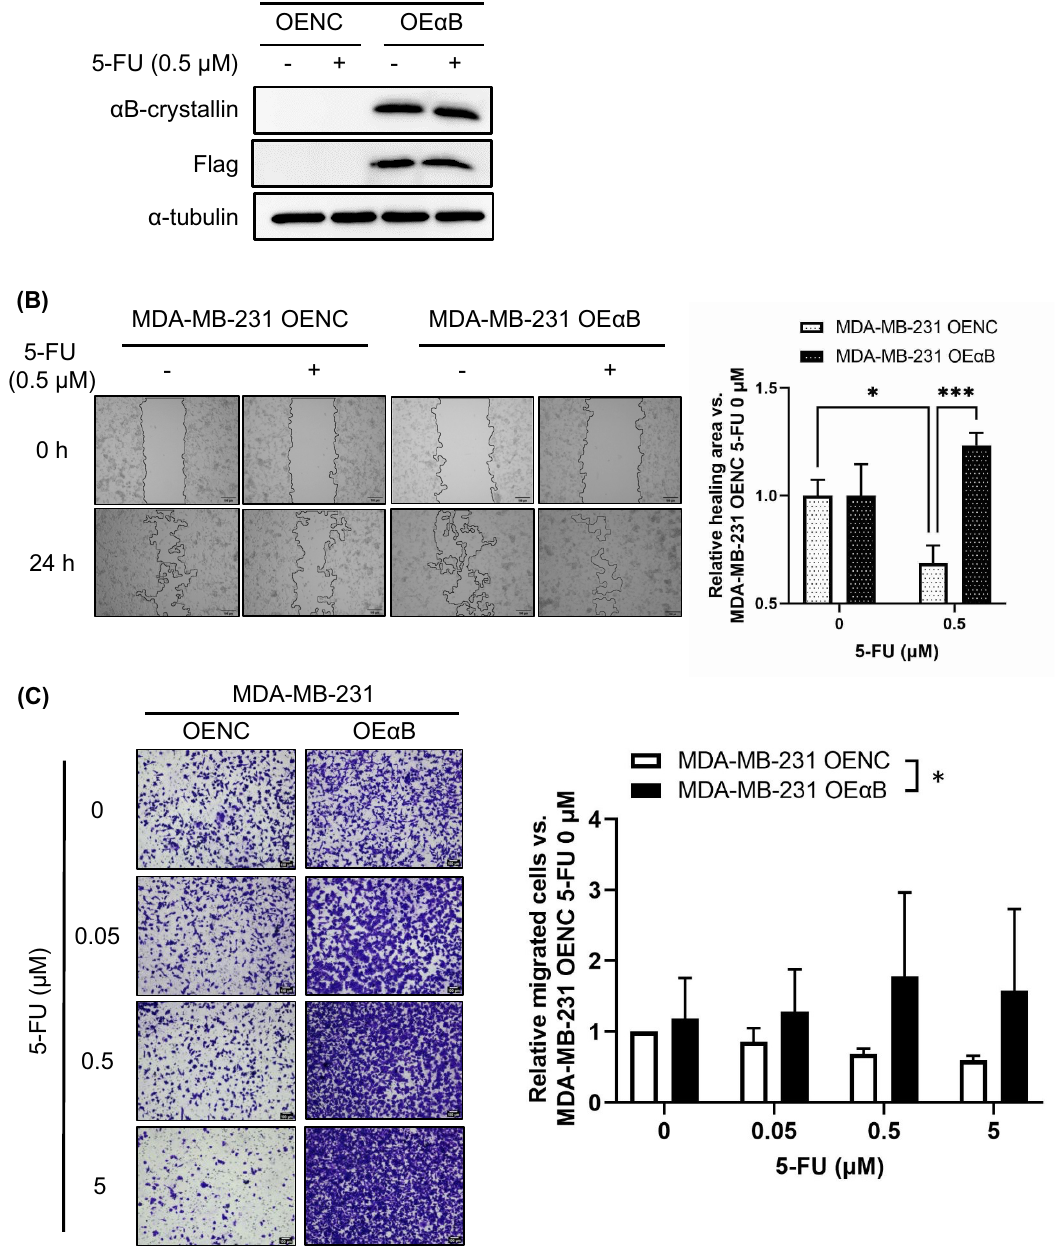
Figure 3. Fluorouracil (5-FU) increased cell motility in MDA-MB-231 cells overexpressing αB-crystallin. ( A ) MDA-MB-231 cells were transfected with αB-crystallin expression plasmid and selected by hygromycin. Stable cell lines harboring negative control vector (OENC) or showing αB-crystallin overexpression (OEαB) were treated with 0.5 μM 5-FU for 24 h. Protein expression was evaluated by immunoblotting analysis. Flag was used to tag αB-crystallin. α-Tubulin was used as the loading control. ( B ) Wound healing assay was performed by using MDA-MB-231 OENC cells and MDA-MB-231 OEαB cells treated with 0.5 μM 5-FU for 24 h. Images of the wound area at the beginning and end of the treatment period were recorded, and ImageJ was used to calculate the relative healing area. Scale bars = 100 μm. Data are presented as mean ± SD, n = 3. * P < 0.05; *** P < 0.001. ( C ) Cells were treated with 0, 0.05, 0.5, or 5 μM 5-FU for 24 h and then added into Transwell inserts. Following a further 24 h of incubation, non-migrated cells were removed and migrated cells in the bottom chamber were fixed. The number of cells that moved through the membrane was determined by using ImageJ. Scale bars = 100 μm. Data are presented as mean ± SD, n = 3. * P < 0.05. The results are representative of two independent